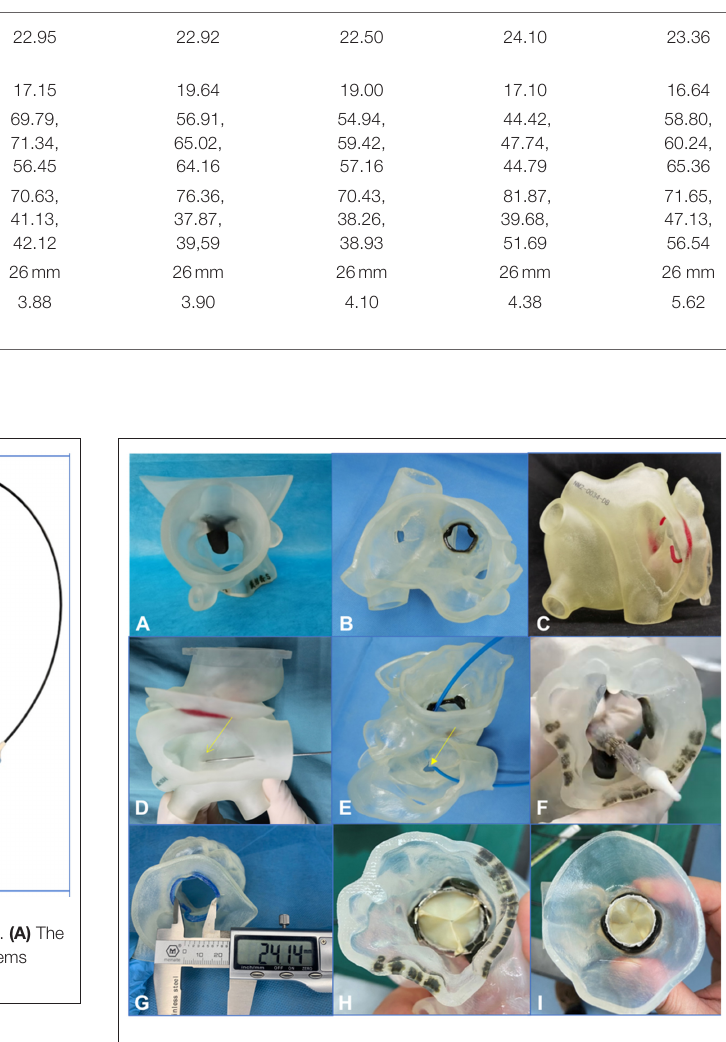
FIGURE 3 | A 3-dimensional printed model was used to simulate the procedure in the bench test (e.g., data for patient 5). (A–C) 3-Dimensional printed model from the plane of the ascending aorta, the left atrium, and the right atrium, respectively. (D–F) An atrial septal puncture was simulated: The catheter went through the atrial septum and released the balloon-expandable valve successfully (the yellow arrows point to the puncture point). (G) The Vernier caliper was used to measure the inner diameter of the biological annulus. The result (24.14mm) was equal to the result from the assessment made using computed tomography angiography. (H,I) Released valve from the plane of the left ventricular outflow tract and the left